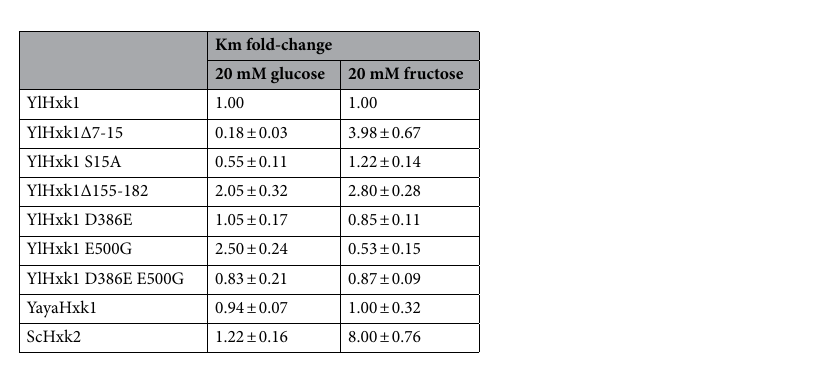
Table 2. Changes in affinity towards glucose and fructose of analysed